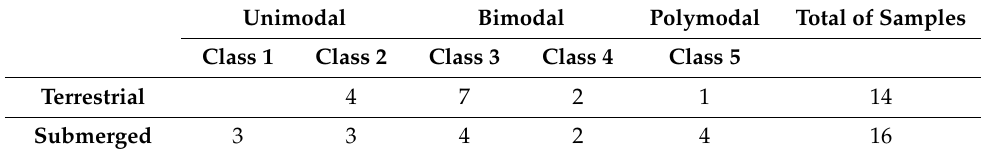
Table 4. Relation between the terrestrial and the submerged samples with their class. Unimodal Bimodal Polymodal Total of Samples Class 1